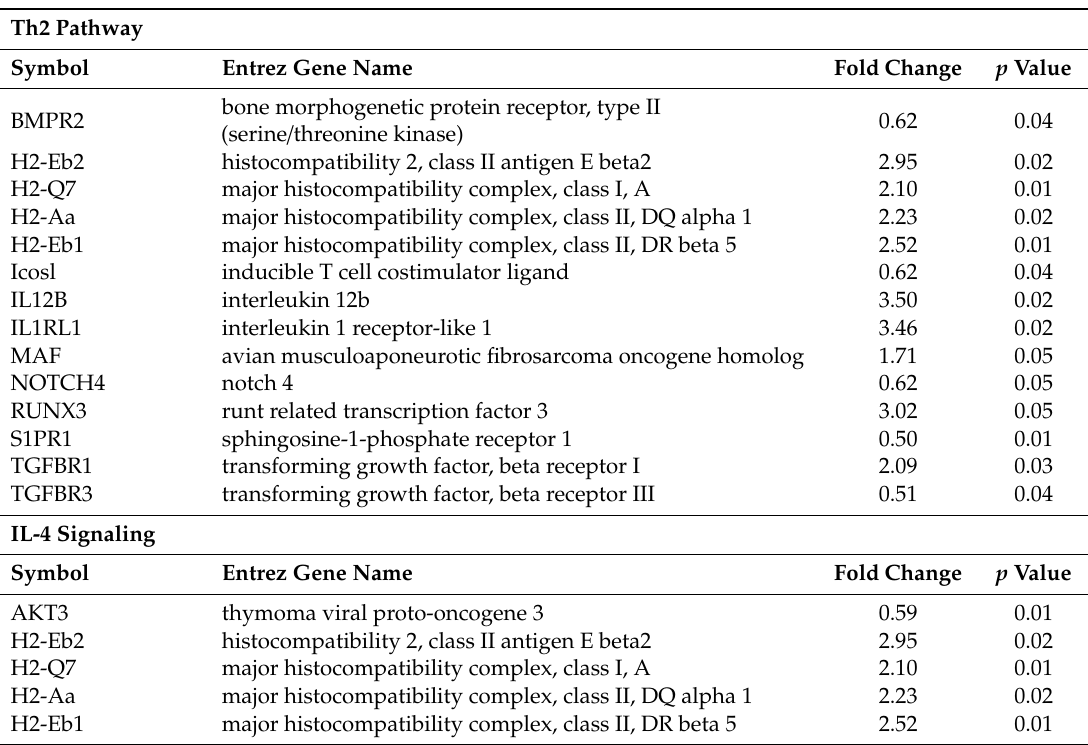
Table 3. Genes altered in the Th2-related signaling